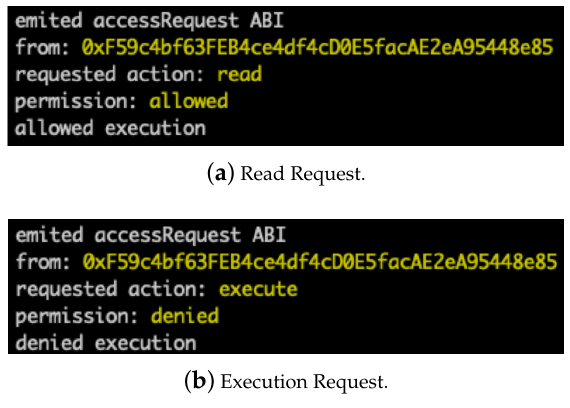
Figure 9. Access Result When Subject addressB Sends